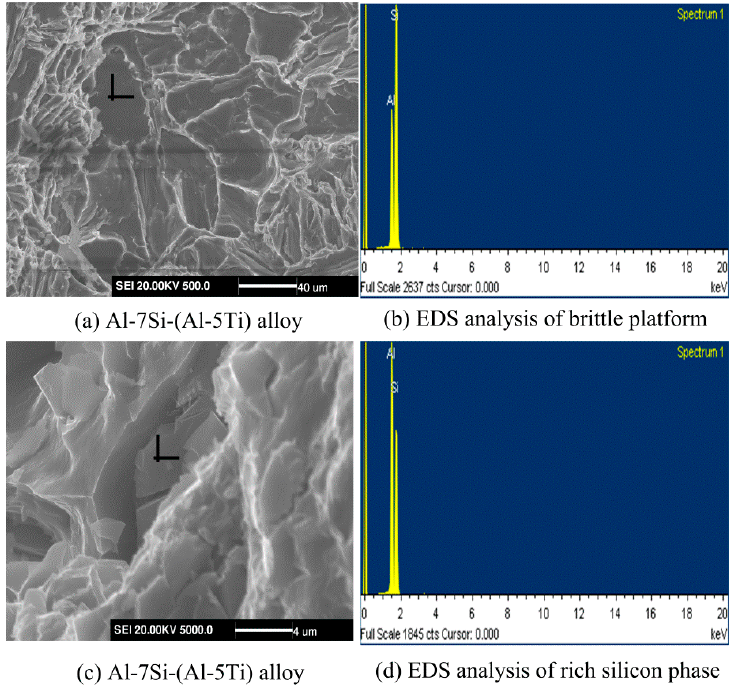
Figure 12. Fracture analysis of Al–7Si–(Al–5Ti) alloy.